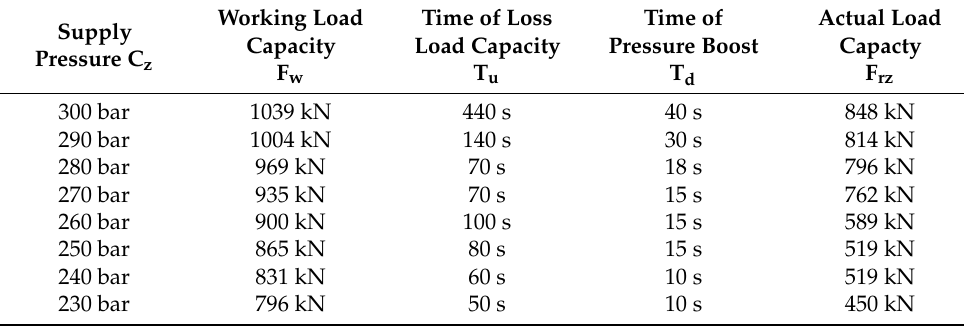
Figure 15. Obtained test results for the adopted relationships: 1—working load capacity, 2—actual load capacity, 3—time of loss capacity, and 4—time of pressure boost. Table 3. The values obtained based on the research carried